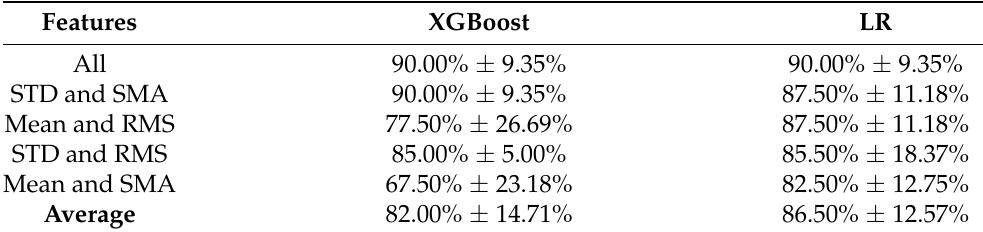
Table 5. XGB and LR accuracy for waving.